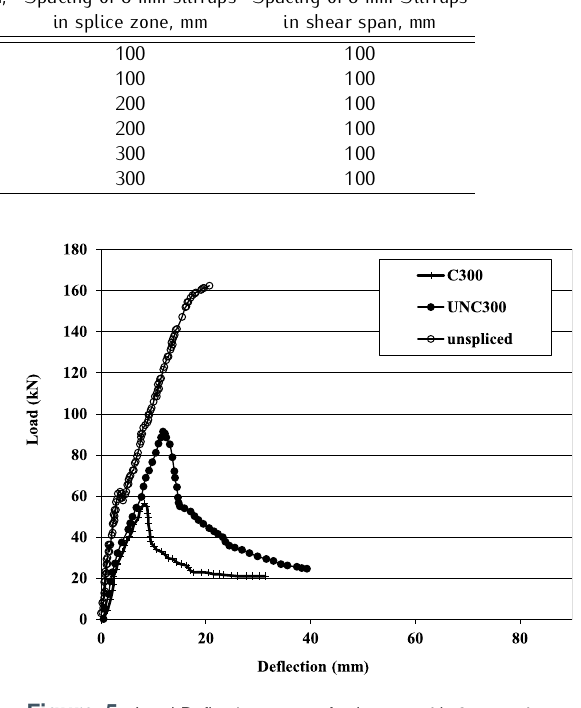
Figure 5. Load-Deflection curves for beams with 8 mm stirrups spaced @ 300.